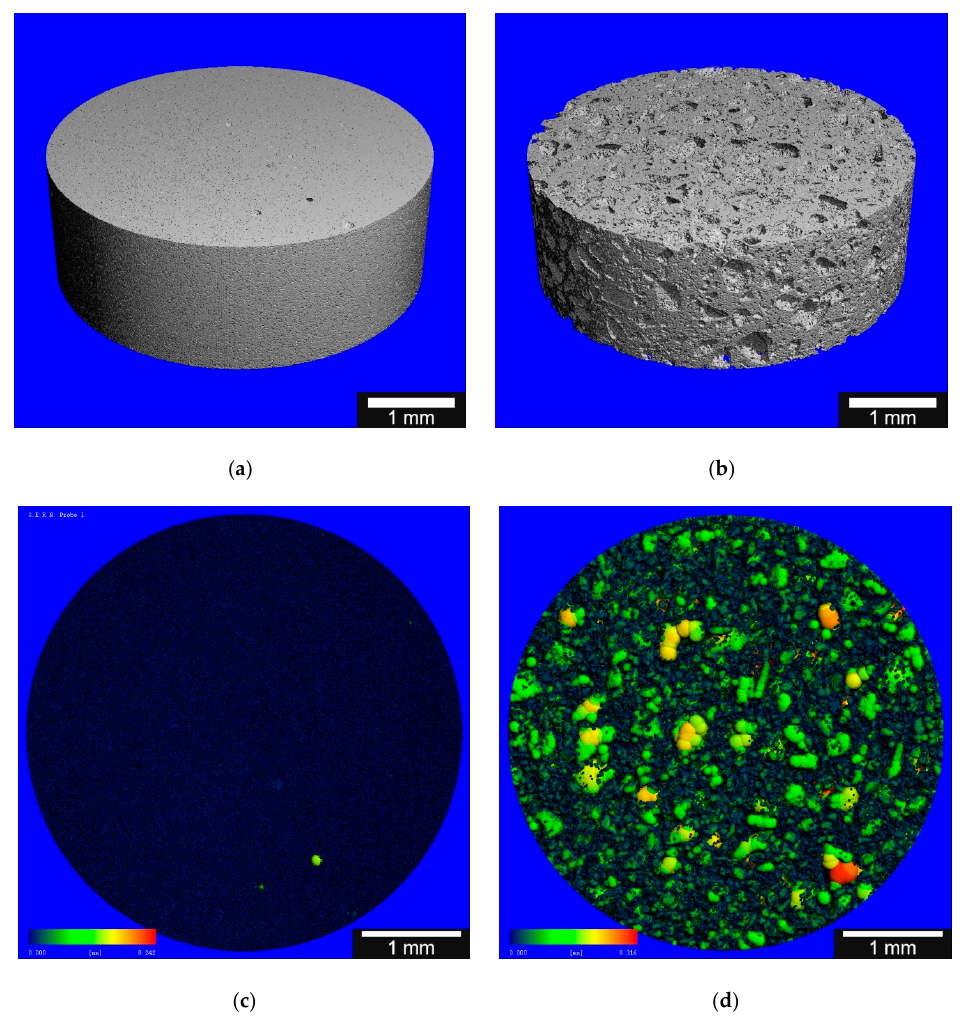
Figure 5. Micro-computed tomography ( µ CT) reconstruction of the different β -TCP ceramics: ( a ): RMS and ( b ): Curasan; µ CT reconstruction of the porosity ( c ): RMS and ( d ): Curasan, the pores are displayed in false colors, the brighter, the larger the pores, the white bar corresponds to 1 mm, the colored bar goes from 0 (dark blue) to 0.316 mm (orange).